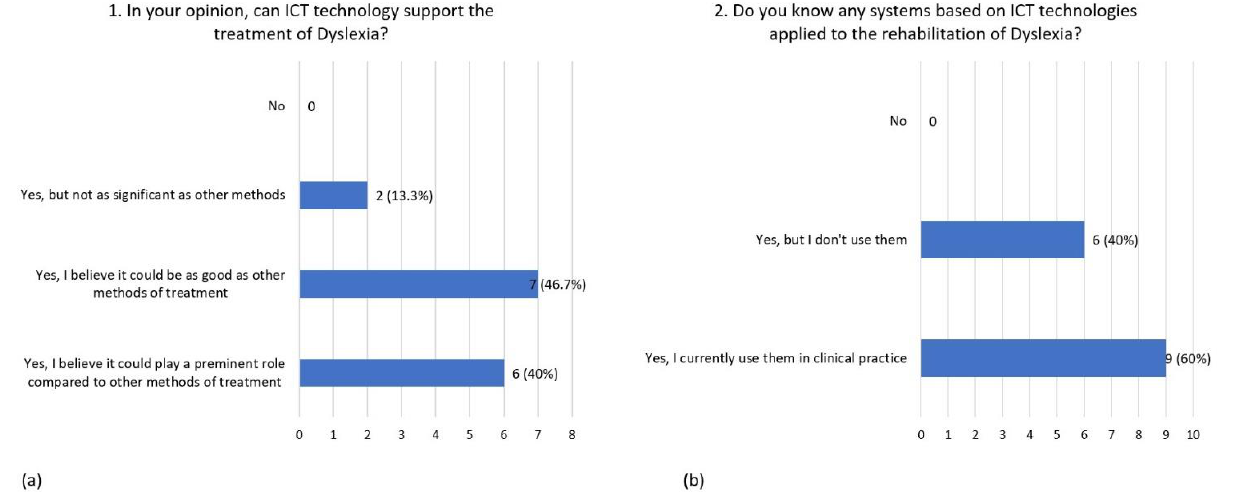
Figure 2. Distribution of responses to question 1 ( a ) and question 2 ( b ) on information and communications technology